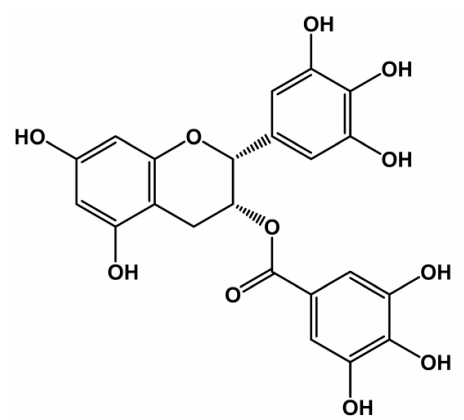
Figure 1. Chemical structure of